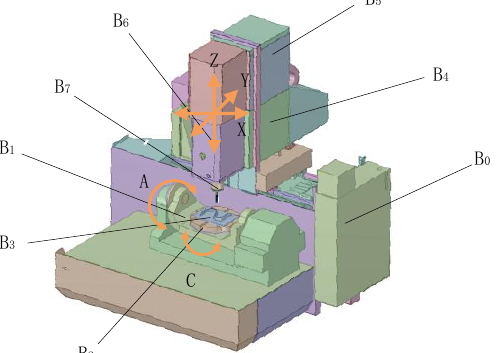
B -Bed body, B -A axis, B -C axis, Figure 1. A–C dual turntable five-axis CNC machine structure. B 0 -Bed body, B 1 -A axis, B 2 -C axis, 0 1 2